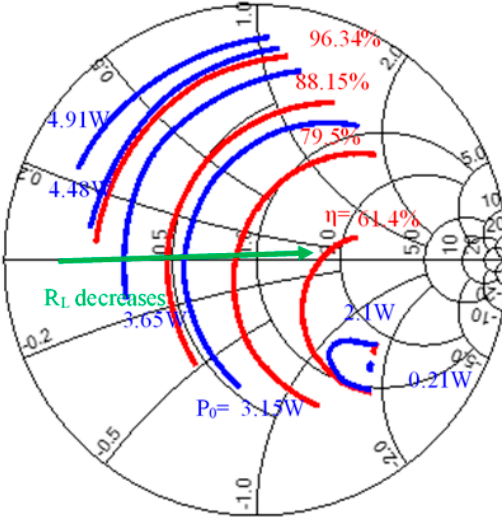
Figure 13. Variations of η and P 0 versus load.